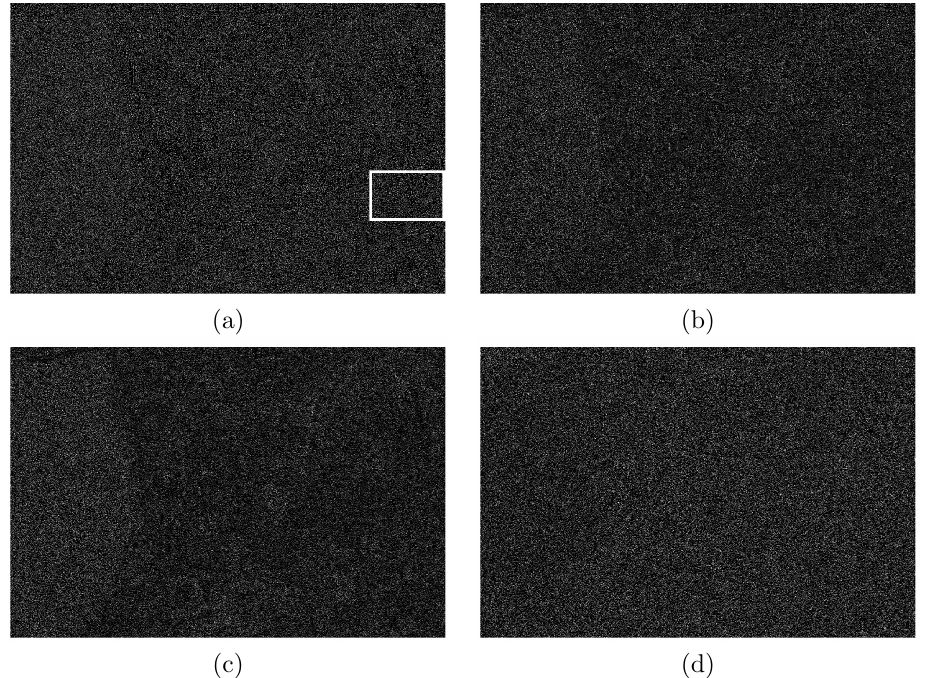
Figure 13. Houston test case. Ratio images obtained after proceeding with the filtering algorithms: ( a ) Kuan, ( b ) PPB-it, ( c ) FANS, and ( d )